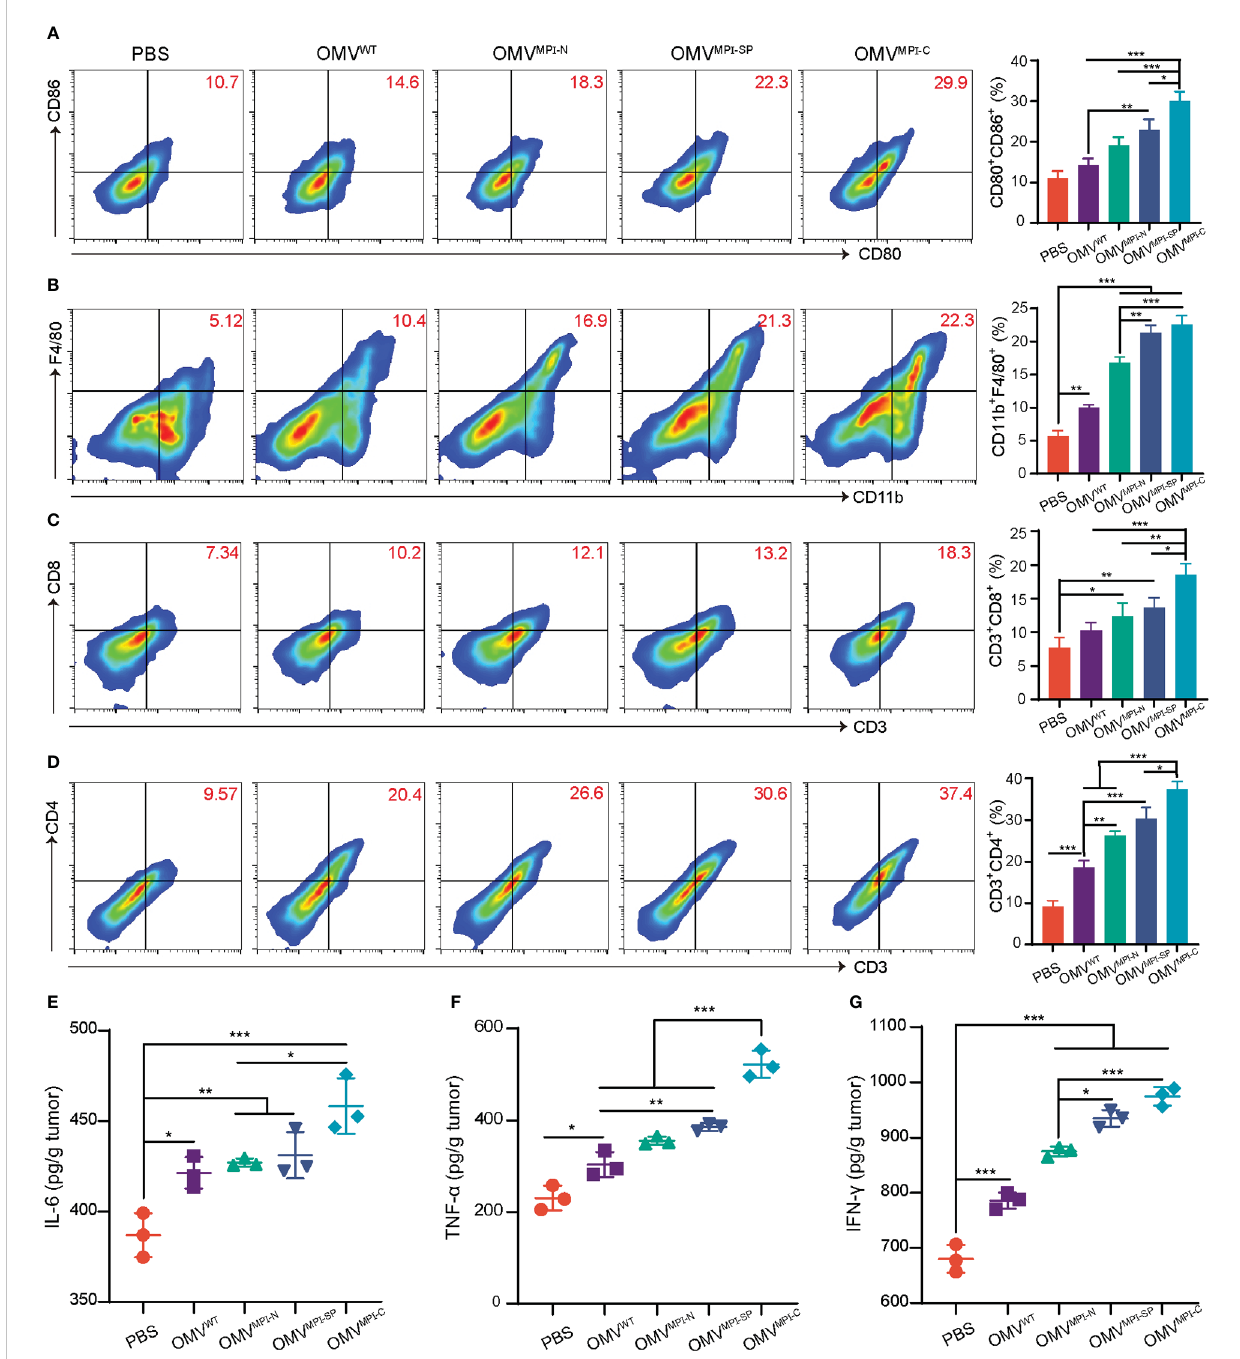
FIGURE 4 Stimulation of antitumor immunity by bioengineered OMVs. (A) Representative FCM analysis results of mature DCs (CD80 + CD86 + gated on CD11c + ) and the corresponding percentages of CD80 + CD86 + DCs in tumors ( n = 3). (B) Representative FCM analysis images of CD11b + F4/80 + macrophages and the corresponding percentages in MB49 tumors ( n = 3). Representative FCM plots of CD3 + CD8 + (C) and CD3 + CD4 + (D) T lymphocyte in fi ltration (both gated on CD45 + ) and the corresponding quantitative analysis ( n = 3). The levels of pro-in fl ammatory cytokines including IL-6 (E) , TNF- a (F) , and IFN- g (G) in tumor tissues after treatment with different OMV formulations ( n = 3). Data are presented as mean ± SD. Statistical signi fi cance was calculated via one-way ANOVA with a Tukey ’ s post-hoc test. * p < 0.05, ** p < 0.01, *** p <